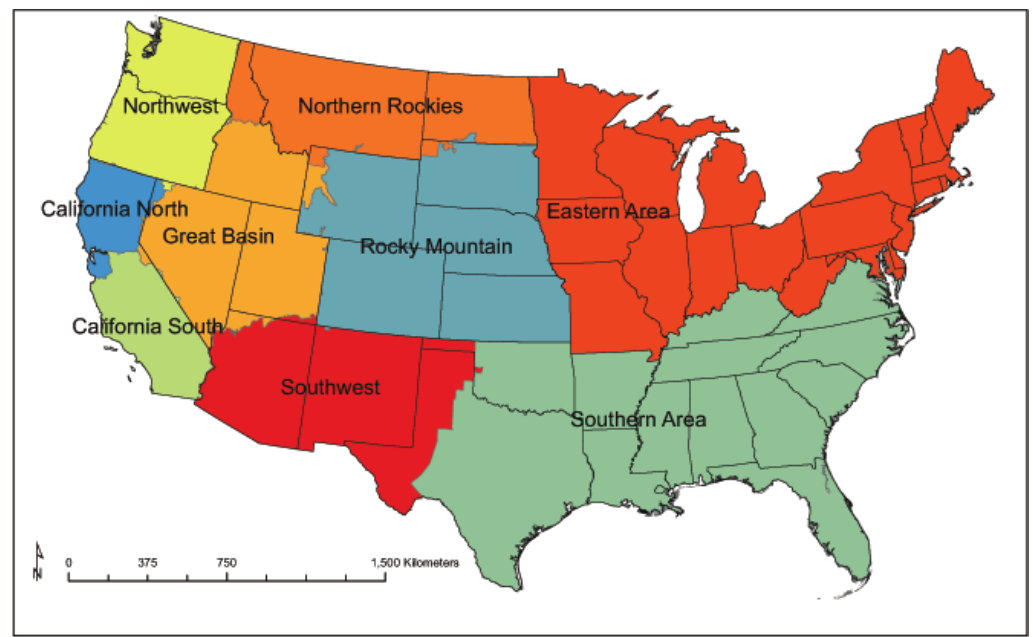
Figure 1. Geographic Area Coordination Center (GACC) regions.